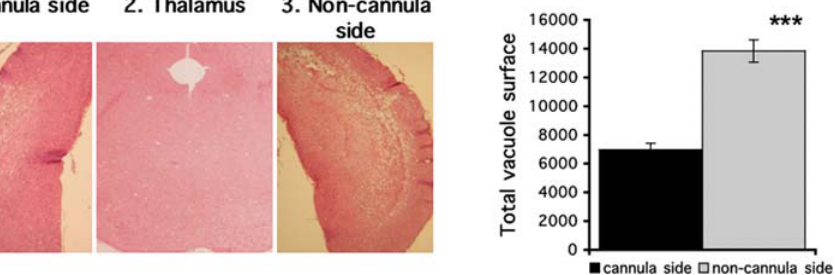
Figure 6. Neurodegeneration in brain regions distant from the guide cannula in prion-infected mice treated with Y PrPQ167R. Tissue sections were stained with hematoxylin and eosin. (1) and (3) correspond to the ipsilateral and contralateral sides of the brain, respectively, in a coronal section located at 3 mm from the cannula implantation site. (2) corresponds to the thalamus area. Bars, 21 m m. The histogram represents the mean total surface of vacuoles in areas 1 and 3. The total vacuolar area was determined in one mouse by drawing the contour of each vacuole present in four squares of 40,000 m m 2 each, using Mercator software. The histogram represents the means 6 s.e.m. Statistical analysis was performed using STATVIEW 5 software. Values were analyzed by ANOVA followed by the PLSD Fisher test (n=4). The total vacuolar area in the treated side was statistically different from that in the non-treated area (***, p , 0.0005).